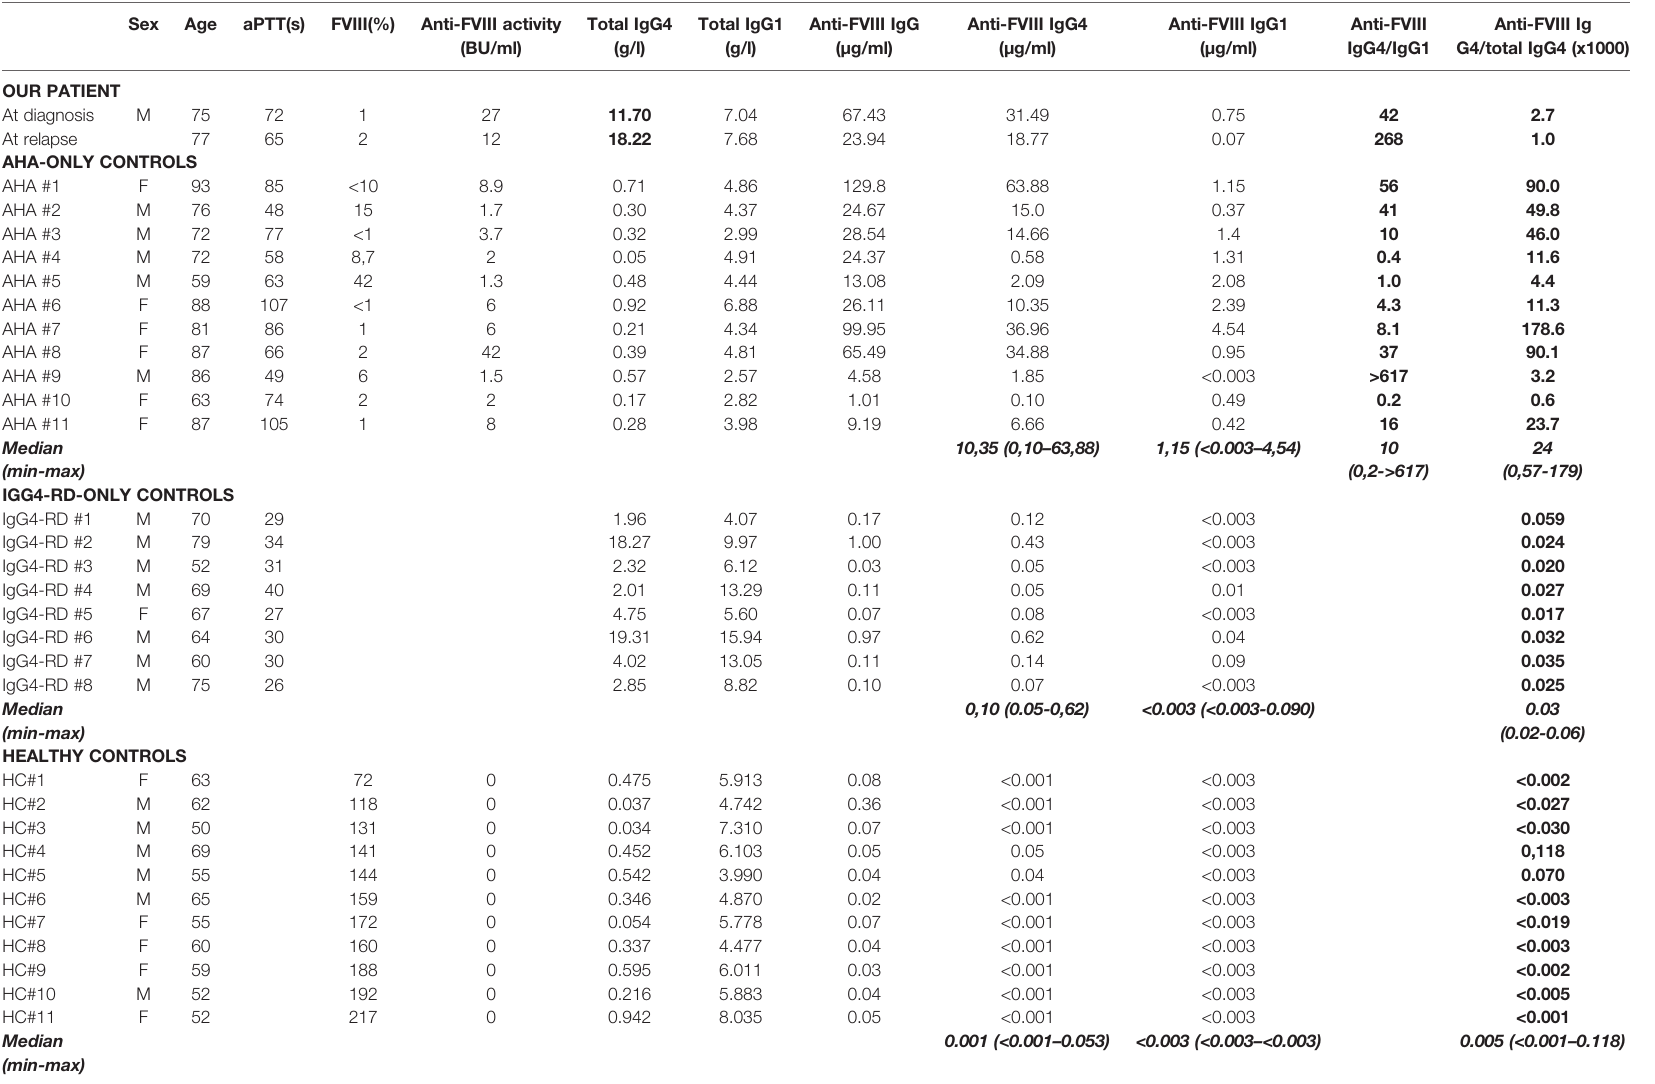
TABLE 2 | Hemostatic and immunological explorations in our patient and in several control groups (AHA-only, IgG4-RD-only and healthy controls).